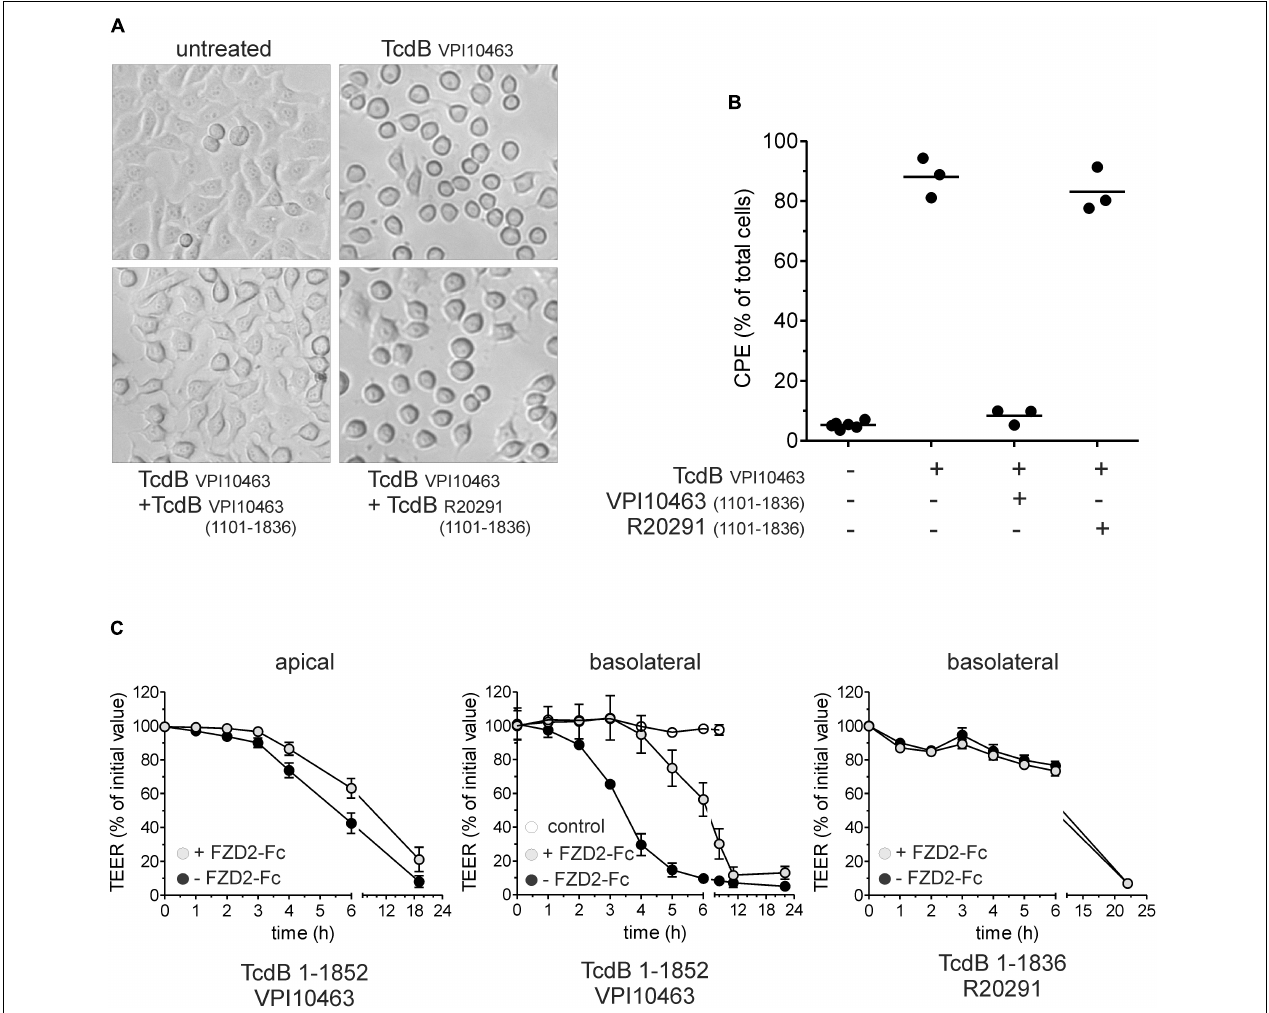
FIGURE 4 | Competition assay with receptor binding domain and frizzled 2 extracellular domain. (A) Micrographs show HEp-2 cells treated with 300 ng/ml TcdB VPI10463 for 3 h. Competition was performed by treatment of cells with TcdB in the presence of 1,000-fold molar excess of the receptor binding fragment TcdB VPI10463 1101–1836 or TcdB R20291 1101–1836. (B) Quantitative evaluation of micrographs from three independent experiments. Shown is the percentage of rounded cells (cytopathic effect; CPE). (C) Effect of CROP-truncated TcdB on transepithelial electrical resistance (TEER) as surrogate for barrier